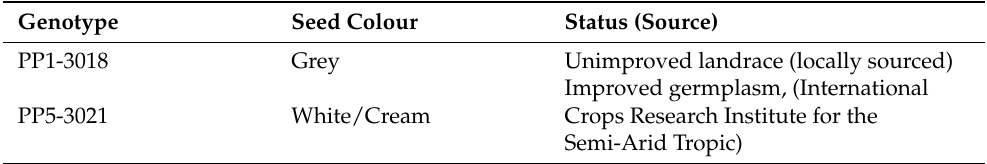
Table 1. Pigeonpea germplasm used in the